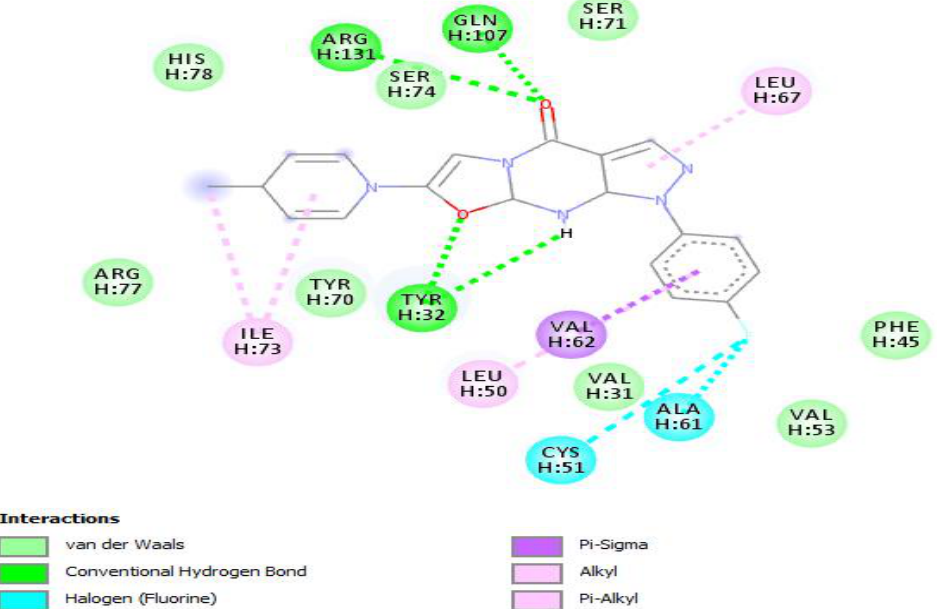
Figure 2. Positioning and interactions of the molecule F0679-0355 inside the active site of receptor HPV16E6 (PDB ID 4xr8).